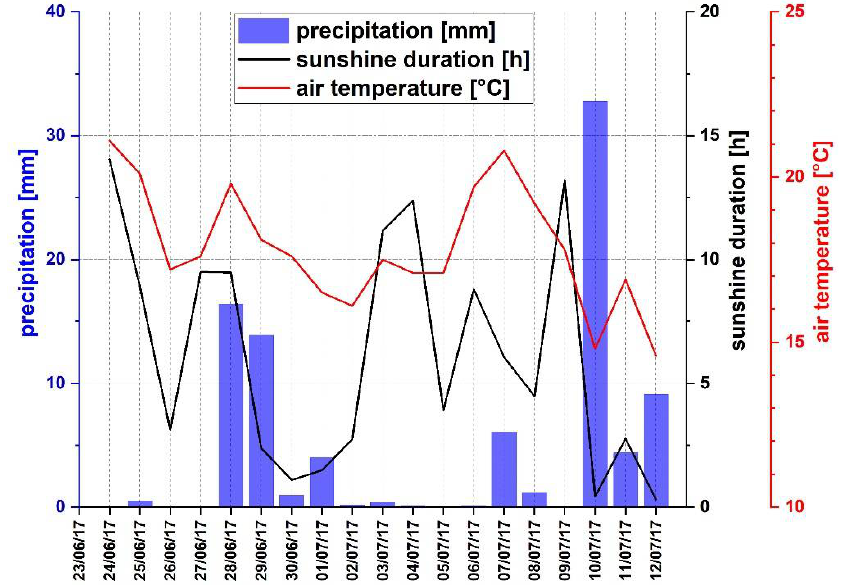
Figure 2. Precipitation [mm], sunshine duration (h) and mean air temperature at 2 m above ground ( ◦ C) during the measuring period. Data were extracted from the Climate Data Center (CDC) of the German Weather Service (DWD) [23]. The illustrated climate data are composed of climate data measured at the weather stations Dresden-Klotzsche, Wittenberg, Magdeburg, Seehausen and Boizenburg.